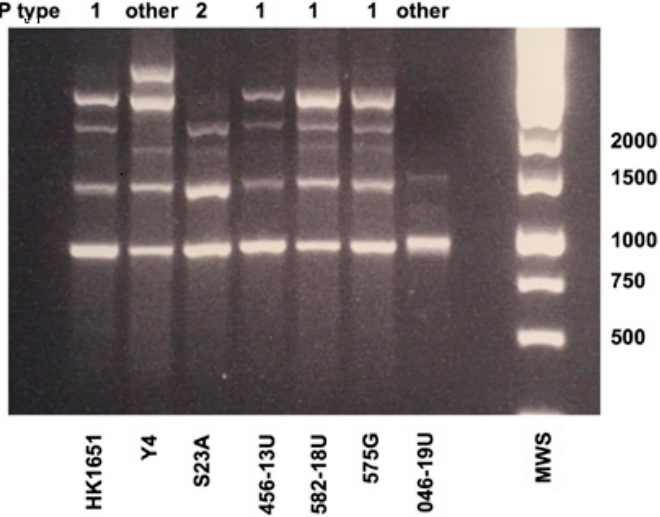
Figure 3. Arbitrarily primed (AP)-PCR genotyping of the seven A. actinomycetemcomitans serotype b strains. Distinct banding patterns distinguish AP-PCR types 1, 2 and “other” (AP-PCR types 3 ‒ 11, as defined previously [13]). Sizes (bp) of selected bands in the DNA molecular weight standard (MWS)